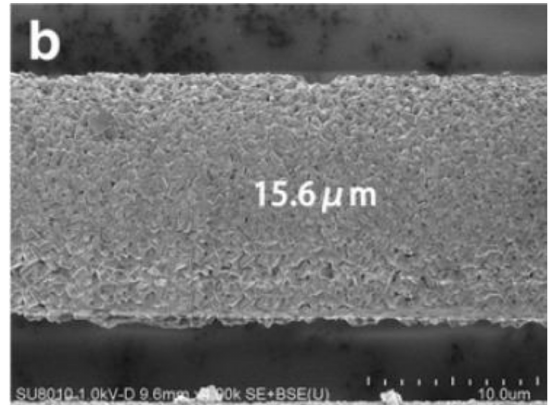
Figure 10. TiO 2 nanoparticle covered PPTA fiber surface [118]. Reprinted with permission from ref. [118]. Copyright 2016